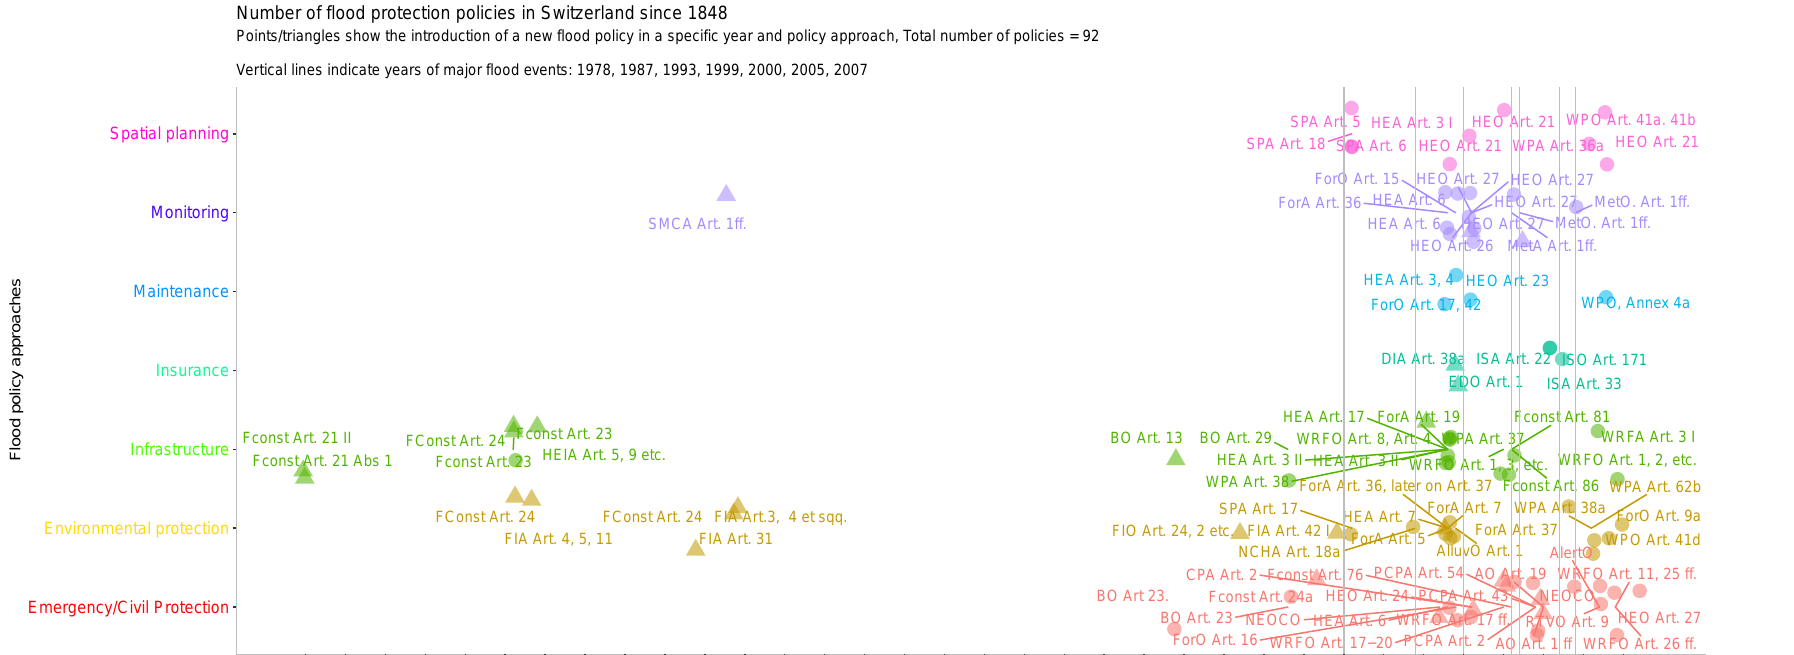
Figure 2. Flood policies in Switzerland over time. Legend: circles = introduced policies that are still in place; triangles = introduced policies later terminated / replaced; AlertO = Alerting- and Security Ordinance, AlluvO = Alluvial Areas Protection Ordinance, AO = Alerting Ordinance, BO = Barrage Ordinance, CPA = Civil Protection Act, DIA = Damage Insurance Act, EDO = Elemental Damage Ordinance, FConst = Federal Constitution of the Swiss Confederation, FIA = Forests Inspectorate Act, FIO = Forest Inspectorate Ordinance, ForA = Forest Act, ForO = Forest Ordinance, HEA = Hydraulic Engineering Act, HEIA = Hydraulic Engineering Inspectorate Act, HEO = Hydraulic Engineering Ordinance, ISA = Insurance Supervision Act, ISO = Insurance Supervision Ordinance, META = Meteorology And Climatology Act, METO = Meteorology And Climatology Ordinance, NCHA = Nature and Cultural Heritage Act, NEOCO = Ordinance of the National Emergency Operations Centre, PCPA = Population- and Civil Protection Act, RTVO = Radio and TV ordinance, SMCA = Swiss Meteorological Central O ffi ce Act, SPA = Spatial Planning Act, WPA